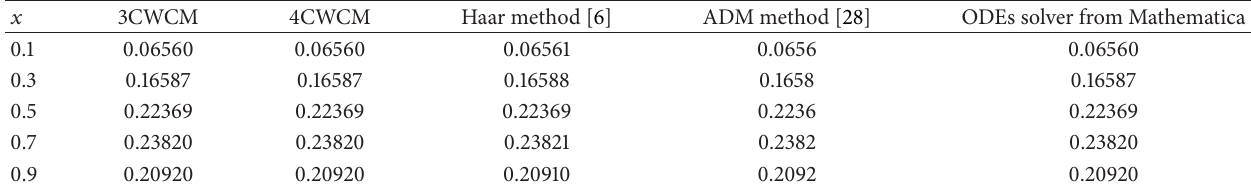
Table 1: Comparison between different solutions for Example 1.